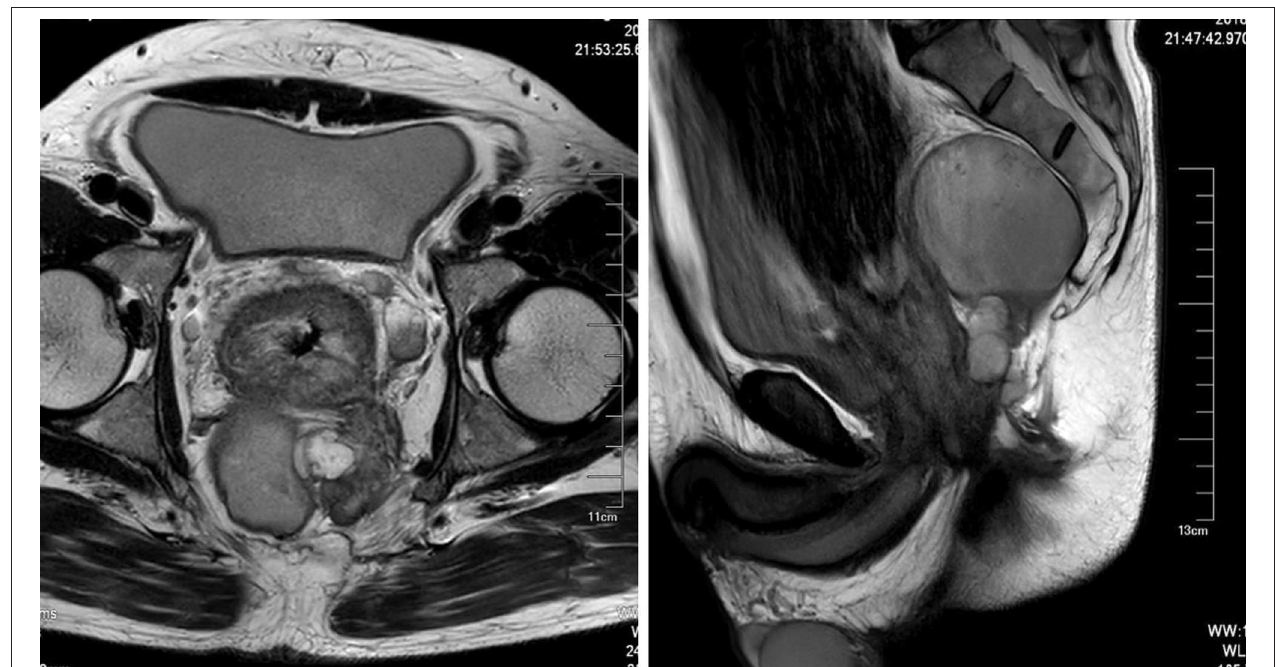
FIGURE 1 | MRI: Several cysts were located in the retrorectal space, which had a clear border with the sacrum but adhered to the rectal tumor.